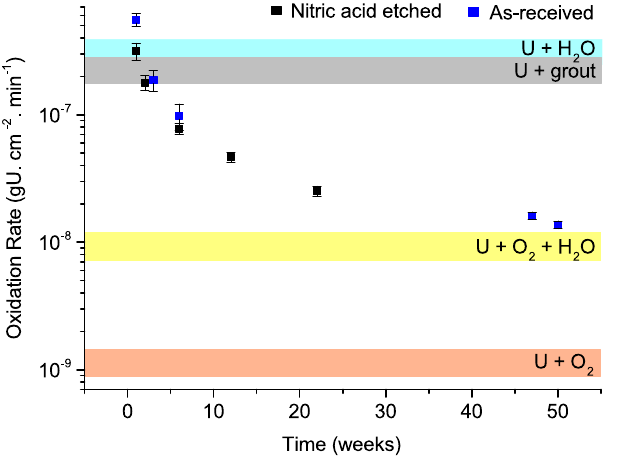
Figure 5. A plot demonstrating the variability in oxide growth rates of grout encapsulated uranium exposed to water vapour over time. Each band of colour represents the oxidation rate at 25 °C calculated from the empirically derived equations displayed at the beginning of this section by 12, 13, 30, 36 . These rates are compared to the rates calculated from the oxide thicknesses determined here. The error bars originate from the errors exhibited in Table 2, which have been processed through the